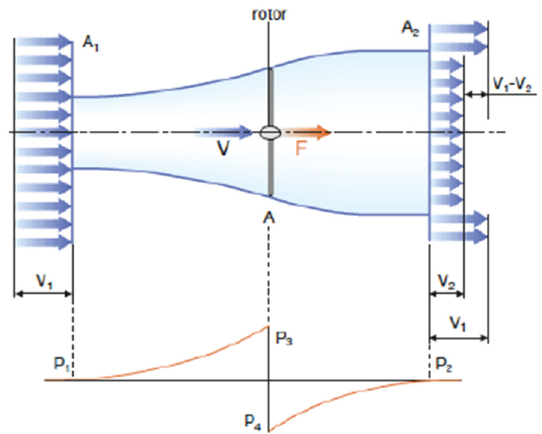
Figure 3. Demonstration of Betz’s theorem.